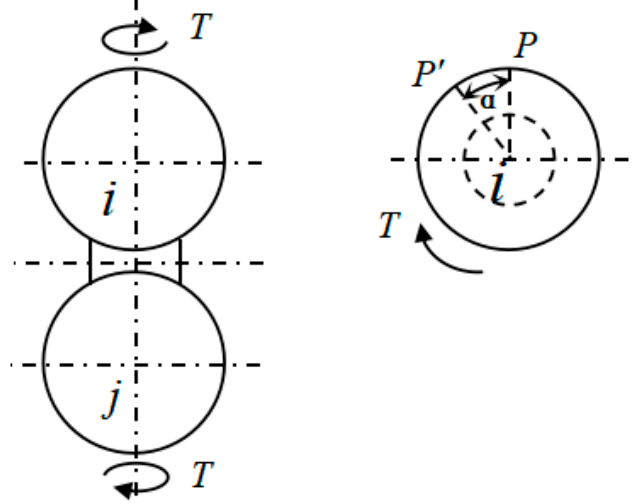
Figure 3. The torsion diagram of a CSE. For a single CSE, a coordinate system was established as shown in Figure 4. Among them, two spheres were symmetrical to the x-z plane. The y-axis coincided with the line connecting the two spheres. R and r c are sphere radius and matrix radius, respectively. The vertical length between the point at any position in the matrix and the y axis is r . The minimum thickness of the substrate at the y-axis is h 0 , and the maximum thickness is h c . The thickness at any position can be expressed by a function of h ( r ) .